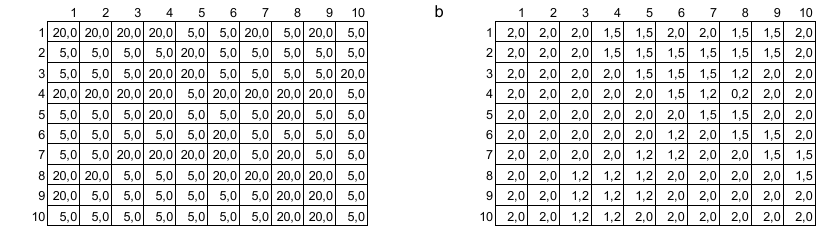
Fig. 8. Zone matrix: a - tracked vehicle traveling speeds (km/h); b – chemical polluted areas (mkg/m 2